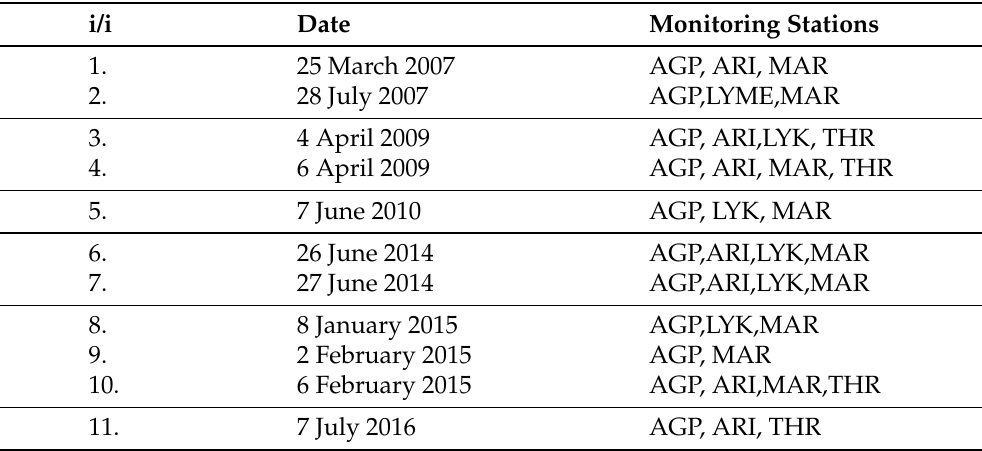
Table 2. Date-periods of the 11 areas (date-periods) of Nikolopoulos et al. [32] that simultaneously (a) are out of stochastic behaviour, (b) BE is below 2.0 and TE below 1.18 and (c) points a and b are commonly found by 3 or more monitoring stations of Table 1. i/i is the index value of the common